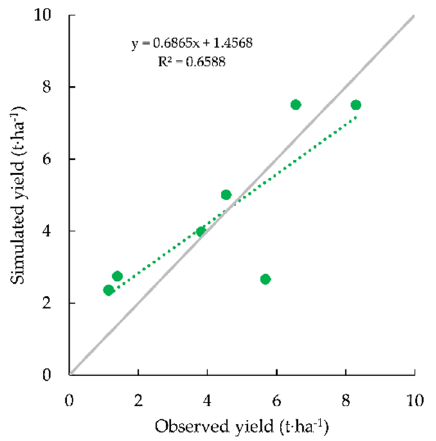
Figure 8. Simulated yield (with data assimilation) vs. observed